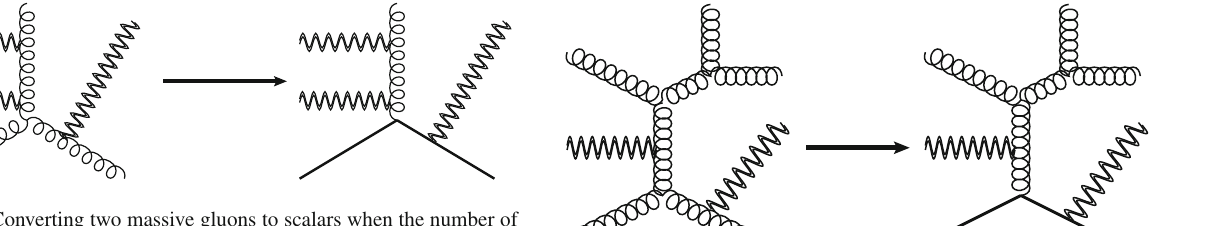
Fig. 6 Converting two massive gluons to scalars when the number of gluons is 3